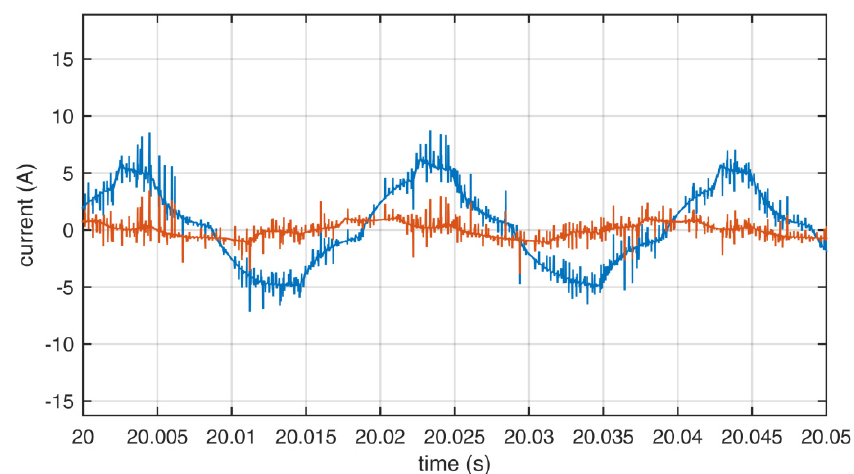
Figure 13. Output currents of the inverter using set C. Blue—L1, red—L2.